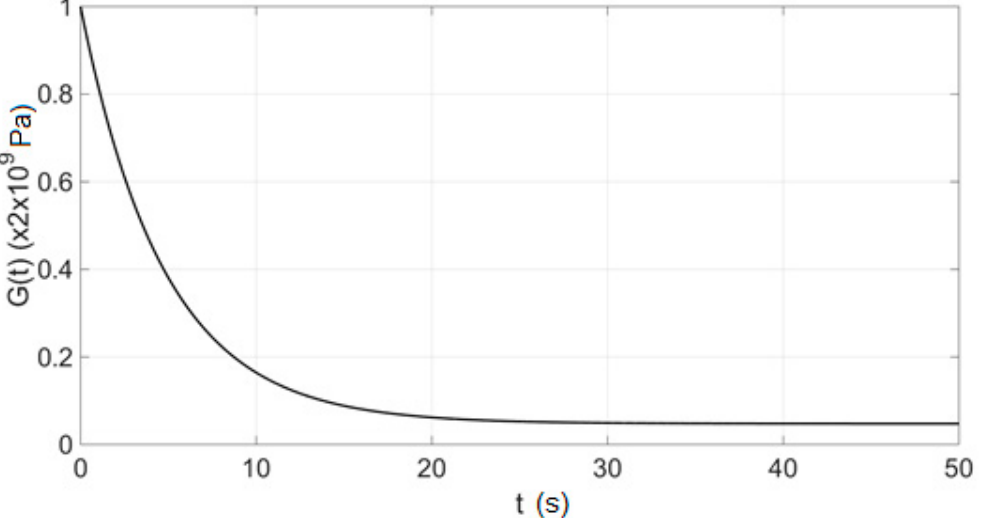
Figure 4. Variation of the relaxation modulus G ( t ) versus time.